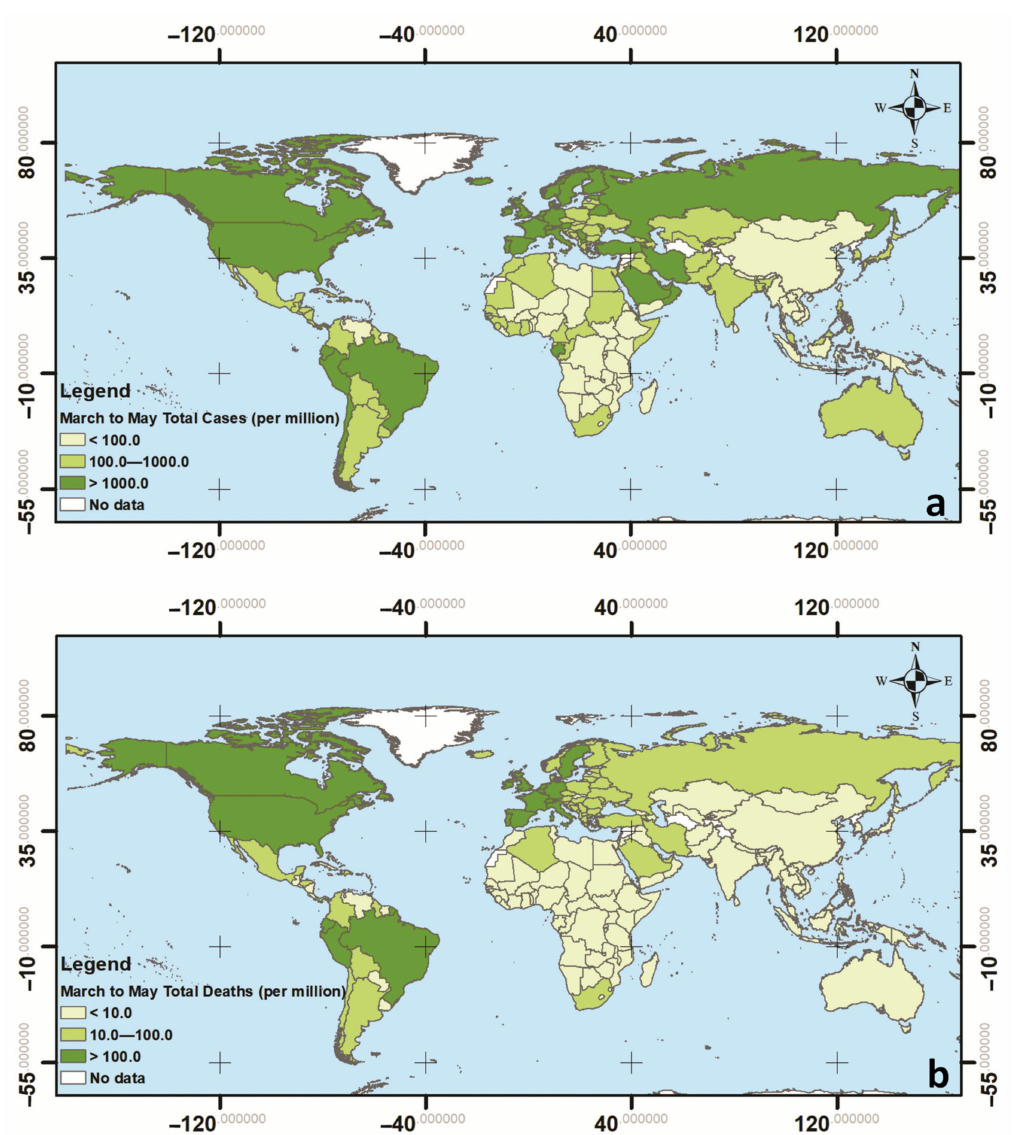
Figure 1. Worldwide distribution of ( a ) COVID-19 cases and ( b ) COVID-19-related deaths for the period of 1 / 3 / 2020–31 / 5 /